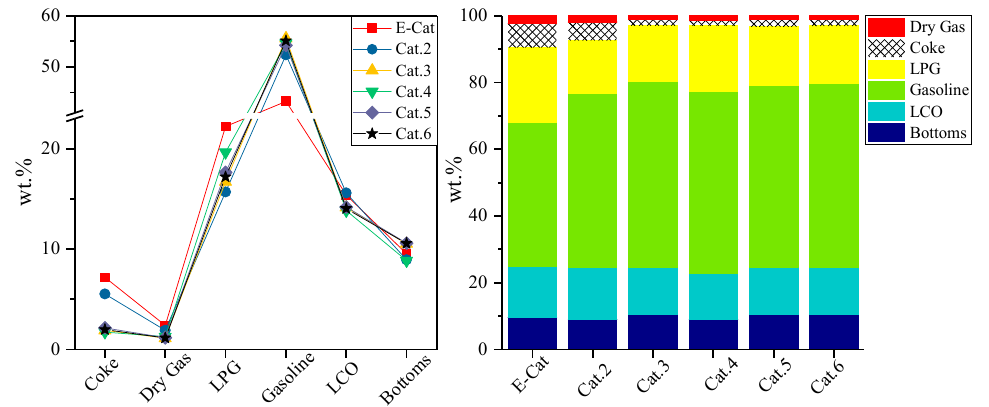
Figure 4. Predicted product distribution at equilibrium conversion of 75% for four compounded catalysts.